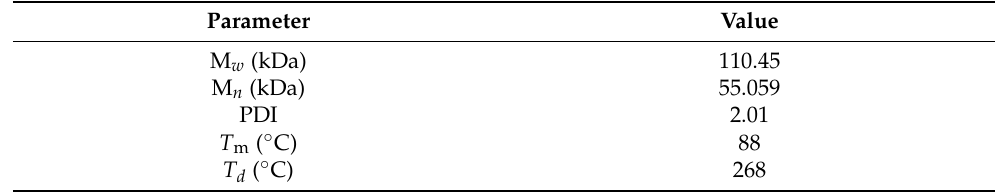
Table 6. Some characteristic features of the PHA produced by Acinetobacter sp. Strain AAAID-1.5.